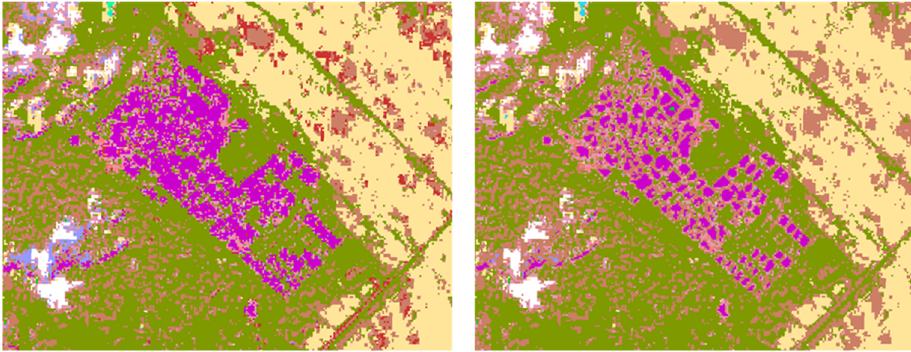
Figure 9. Višegrad Dam aquatic site ( top ) and tyre graveyard in Kuwait ( bottom ) as the original ANN classification ( left ) and result after the decision tree filtering ( right ).